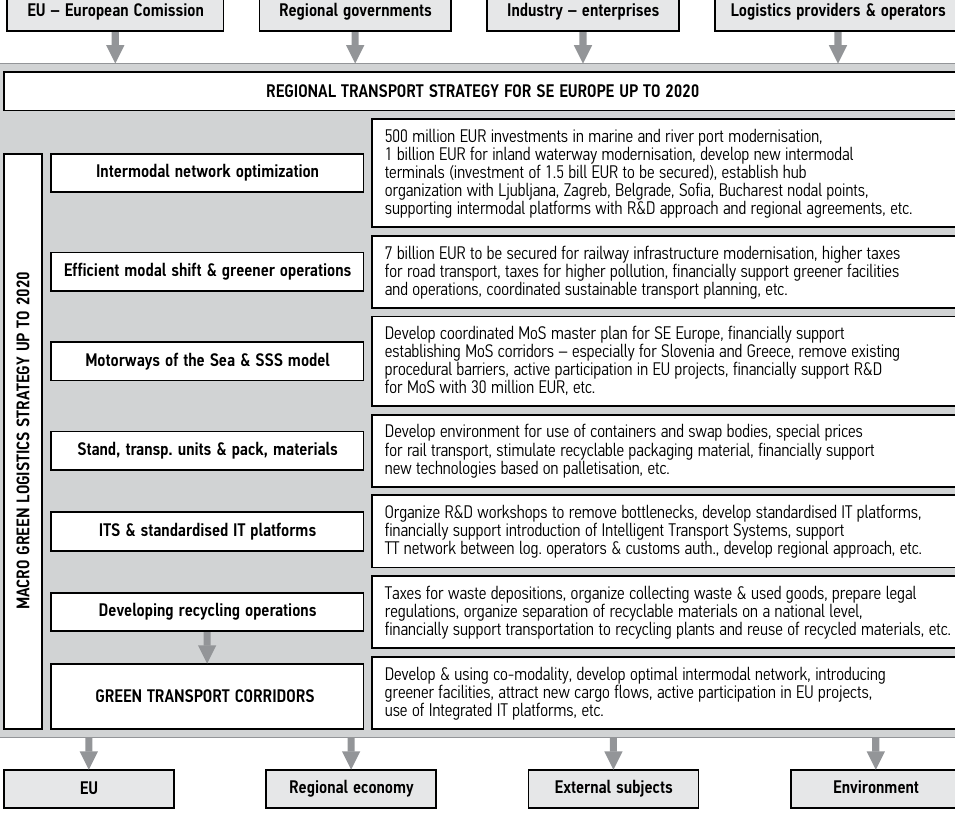
Fig. 1. Macro green logistics strategy for South East Europe ( source : model worked out by